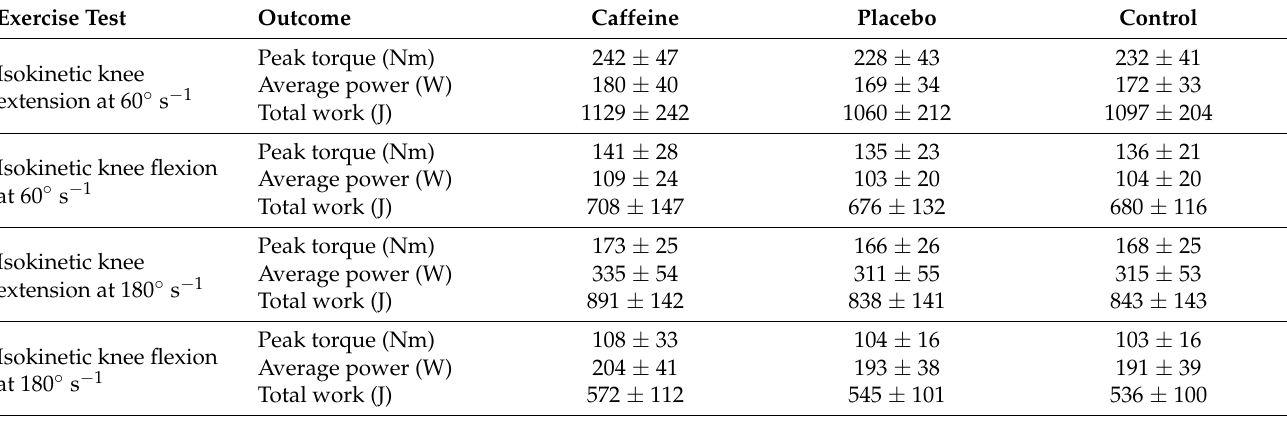
Table 1. Summary of the isokinetic performance data recorded during the three study